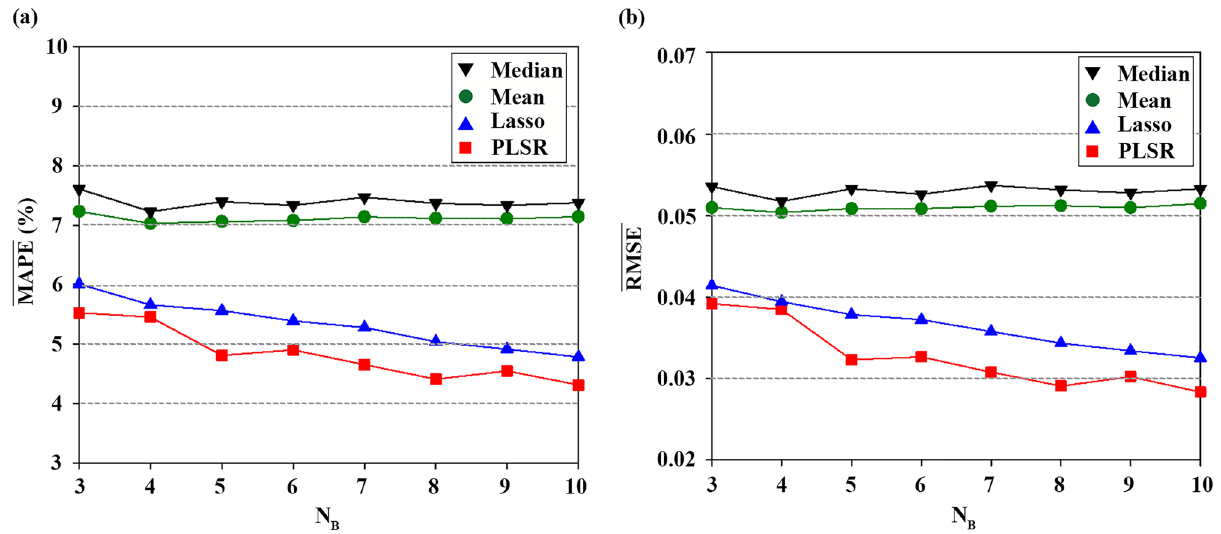
Figure 6. Forecasting accuracy of GRU-based ensemble model according to N B : ( a ) MAPE (%) for different meta models, ( b ) RMSE for different meta models.